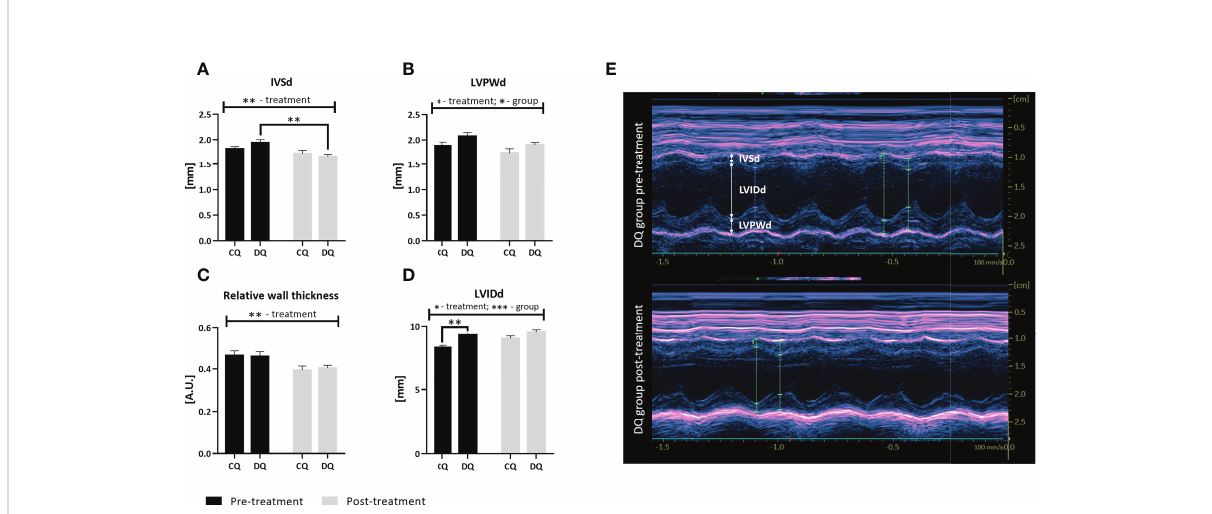
FIGURE 2 The assessment of LV structural parameters at two different time points – pre-treatment (week 0 – prior to the administration of Que) and post-treatment (week 6 – at the end of the Que treatment course). (A) Interventricular septal thickness in end-diastole (IVSd). (B) Left ventricular posterior wall thickness in end-diastole (LVPWd). (C) Relative wall thickness. (D) Left ventricular internal diameter in end-diastole (LVIDd). (E) Representative echocardiographic image of LV wall structure captured in Motion-mode in DQ group pre-treatment vs. post-treatment. Data are presented as mean ± SEM and statistical differences as * p < 0.05, **p < 0.01, *** p < 0.001 (two-way ANOVA paired with Holm-Sidak´s multiple comparisons test).